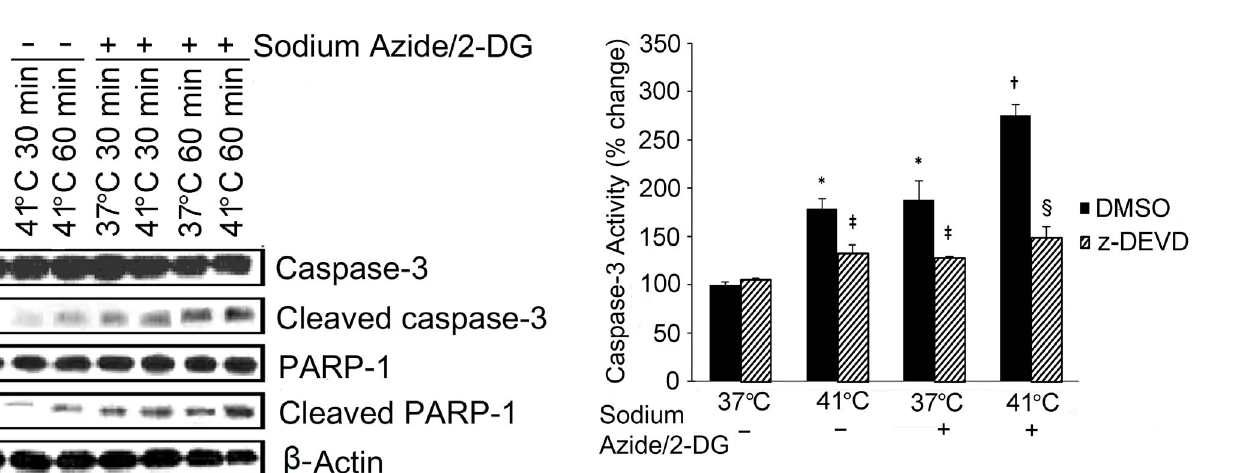
Figure 7. Caspase-3 activity was increased following the treatments. Sodium azide/2-DG, increased temperature or combina- tion of sodium azide/2-DG plus increased temperature resulted in increased caspase-3 activity. Cells were pre-incubated with DMSO or caspase-3 inhibitor (z-DEVD-FMK) for 2 hours, and then cells were subjected to the indicated treatments for 1 hour. * denotes significant difference from the 37 u C DMSO cell ( p , 0.01); { denotes significant difference from the 37 u C plus sodium azide/2-DG and 41 u C alone cells ( p , 0.05); ` ( p , 0.05) and 1 ( p , 0.01) denote significant difference from the DMSO groups, respectively. n=3.